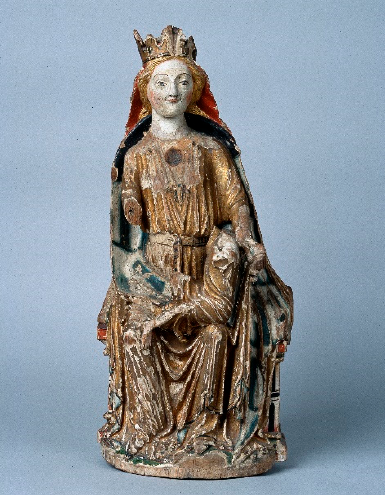
Figure 10. Madonna from Grong. Polychrome oak, 13th century. Trondheim, NTNU University Museum, Inv. No. T1947. Photo: Per E. Fredriksen (CC BY-SA 4.0).